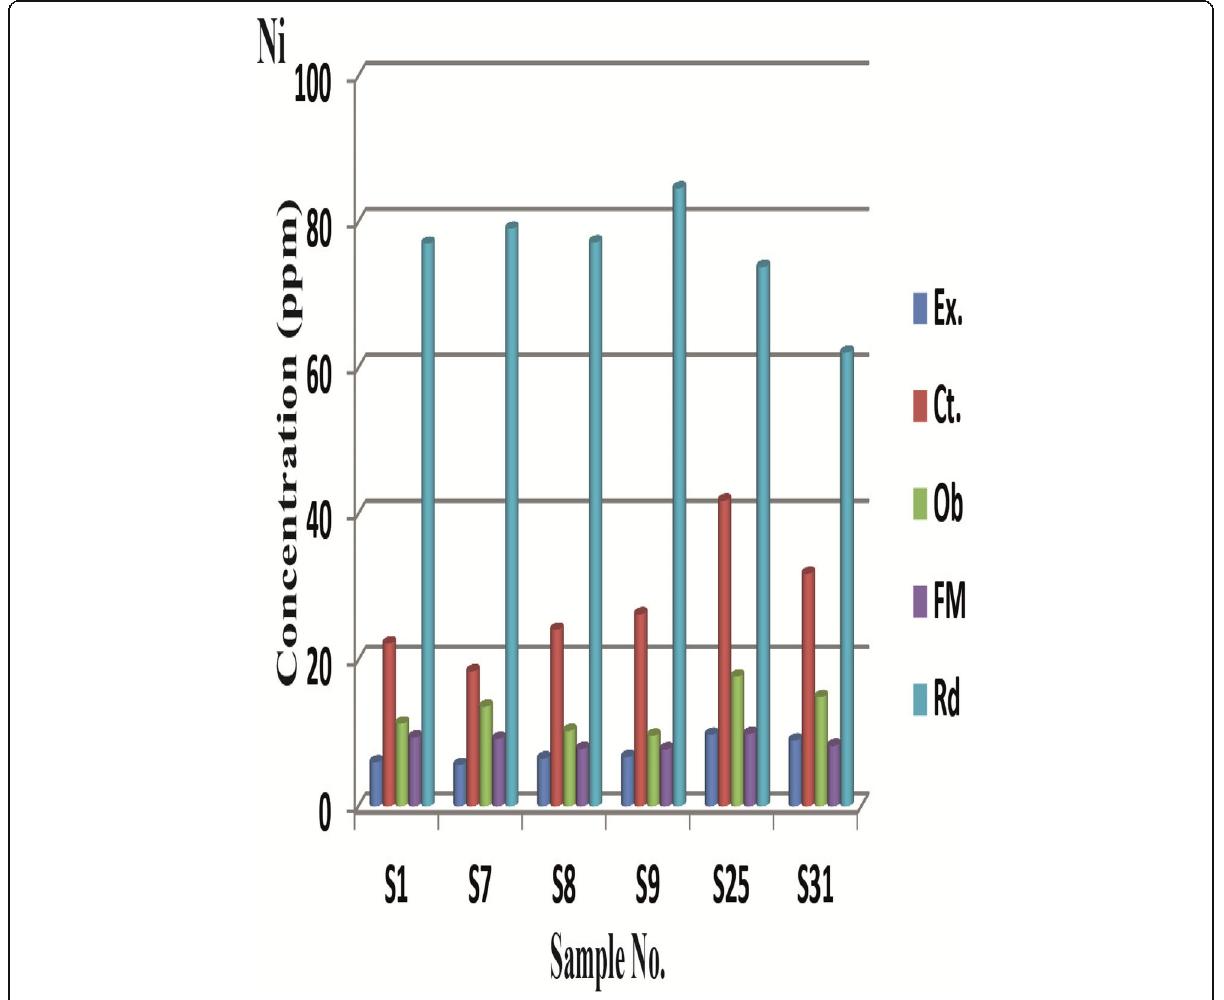
Fig. 7 Relative distribution of Ni among the various soil fractions in the study